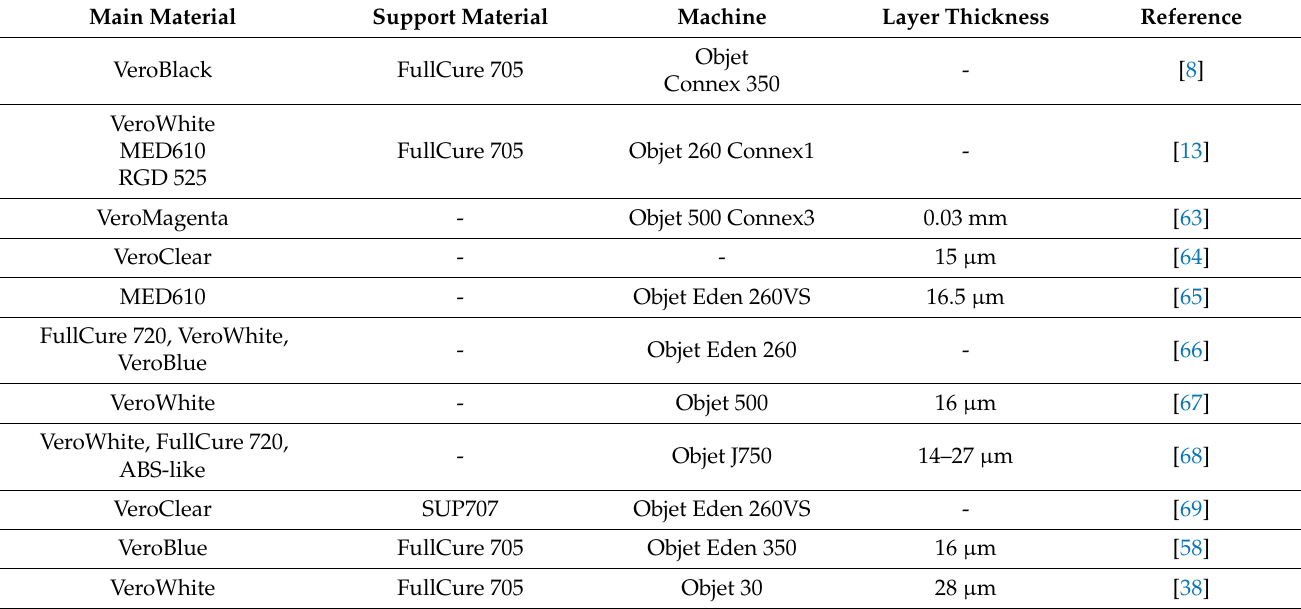
Table 1. Materials, machines and layer thicknesses used in the